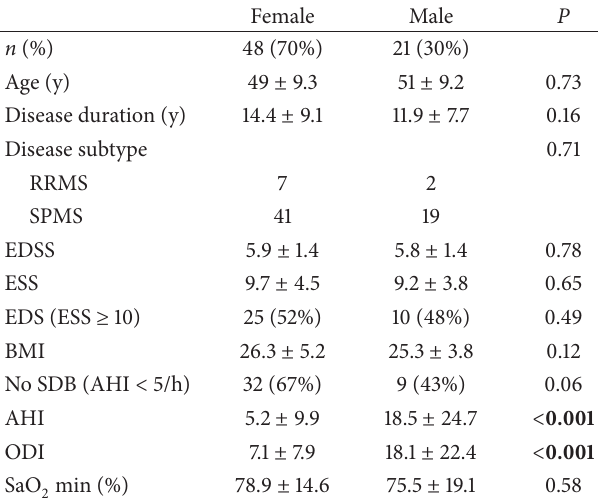
Table 2: Gender-related differences in MS patients with severe